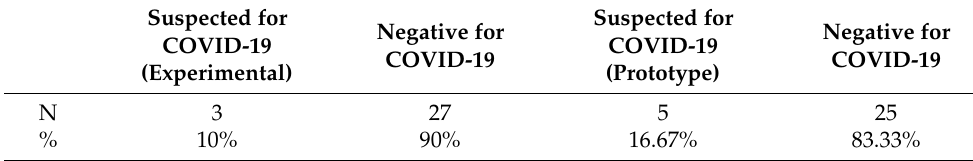
Table 9. Experimental results vs. detection program results.